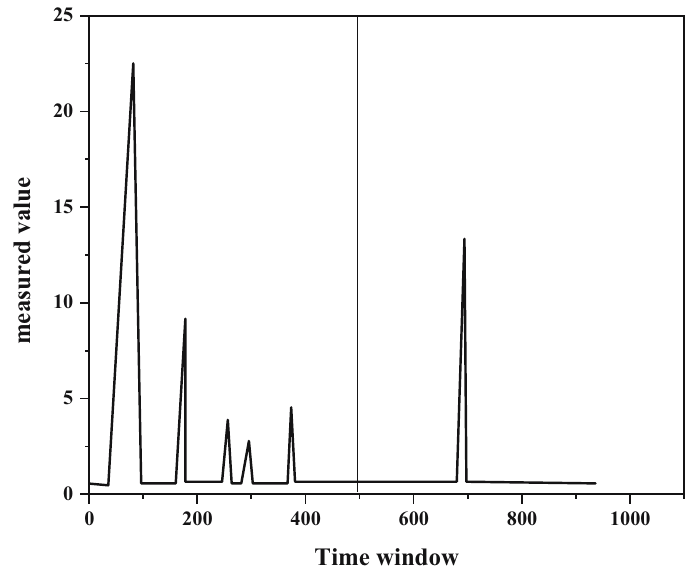
Figure 4: The original data attack index change graph.